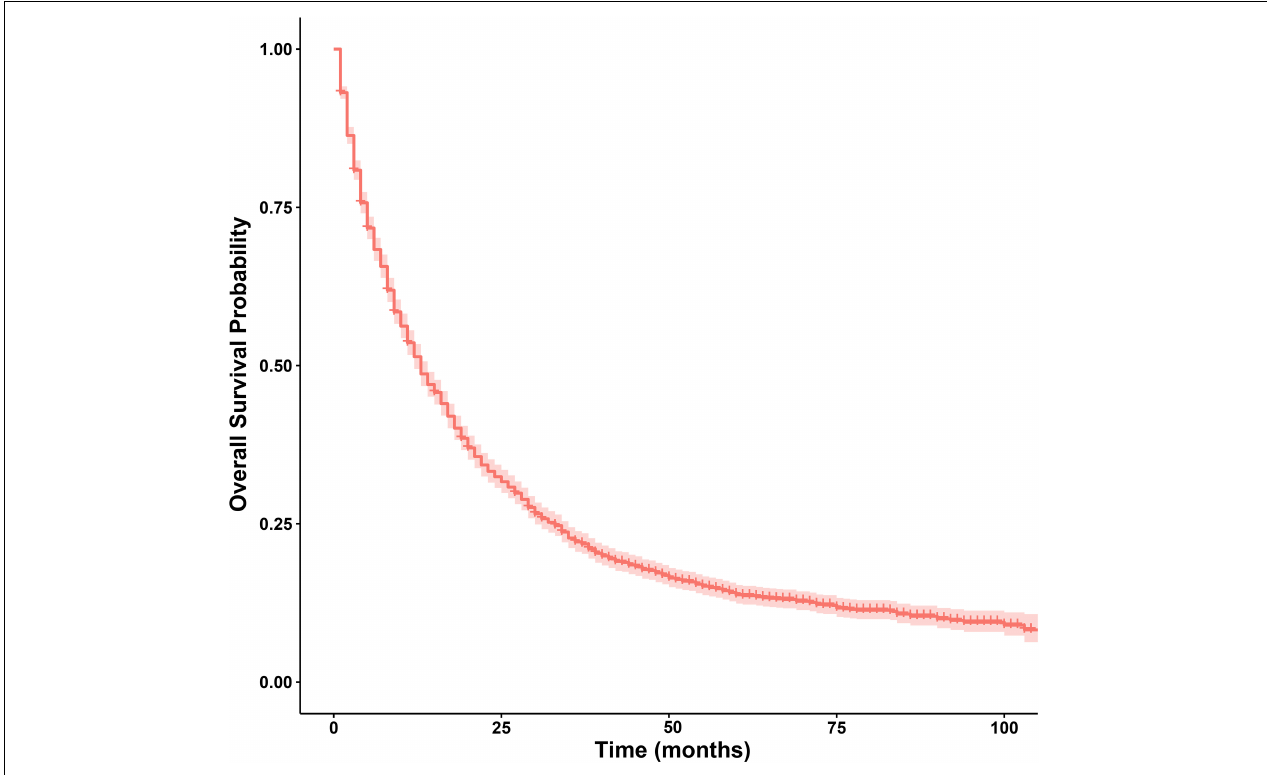
FIGURE 4 | Survival curve of patients with